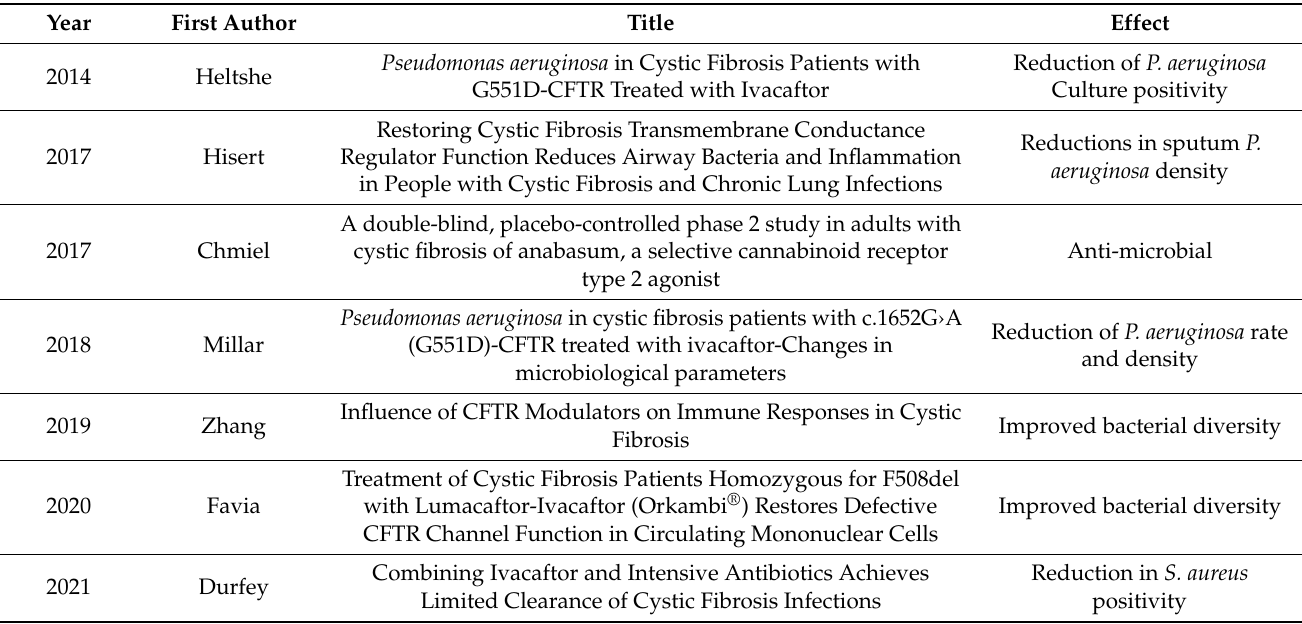
Table 1. Overview of clinical studies demonstrating an anti-microbial effect of CFTR